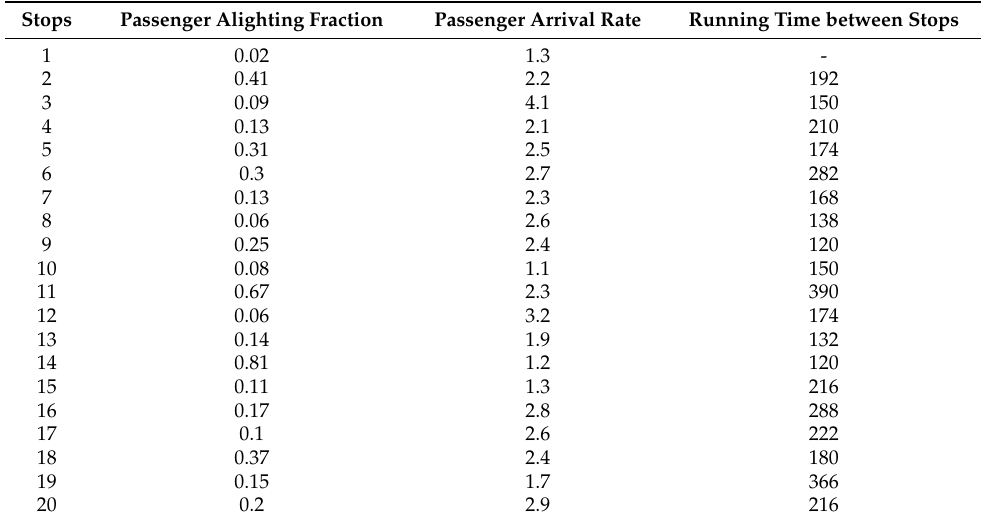
Table A1. Values of stochastic parameters in scenario one.